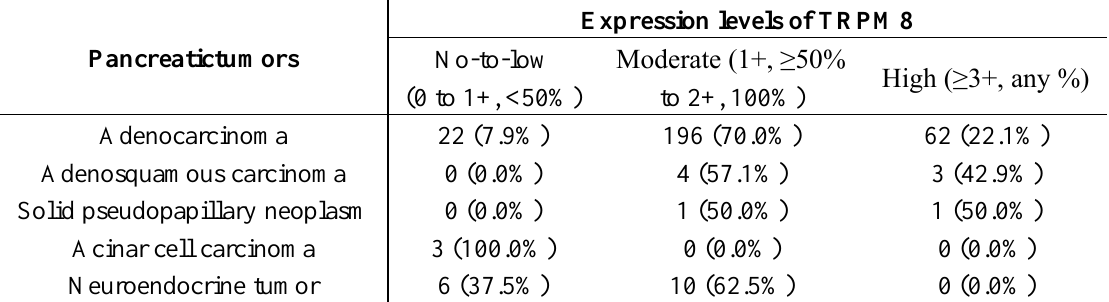
Table 1. Expression of TRPM8 in various types of histopathology in pancreatic tumors with regard to the intensity of immunoreactivity and the percentage of positive cells. The total number of cases examined is 308. The values represent the number of specimens with the corresponding proportions in